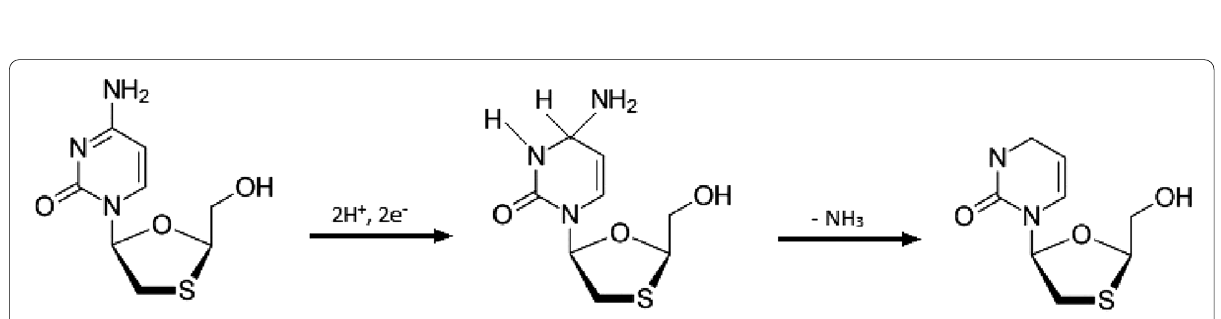
Scheme 1 Electrochemical reduction mechanism of